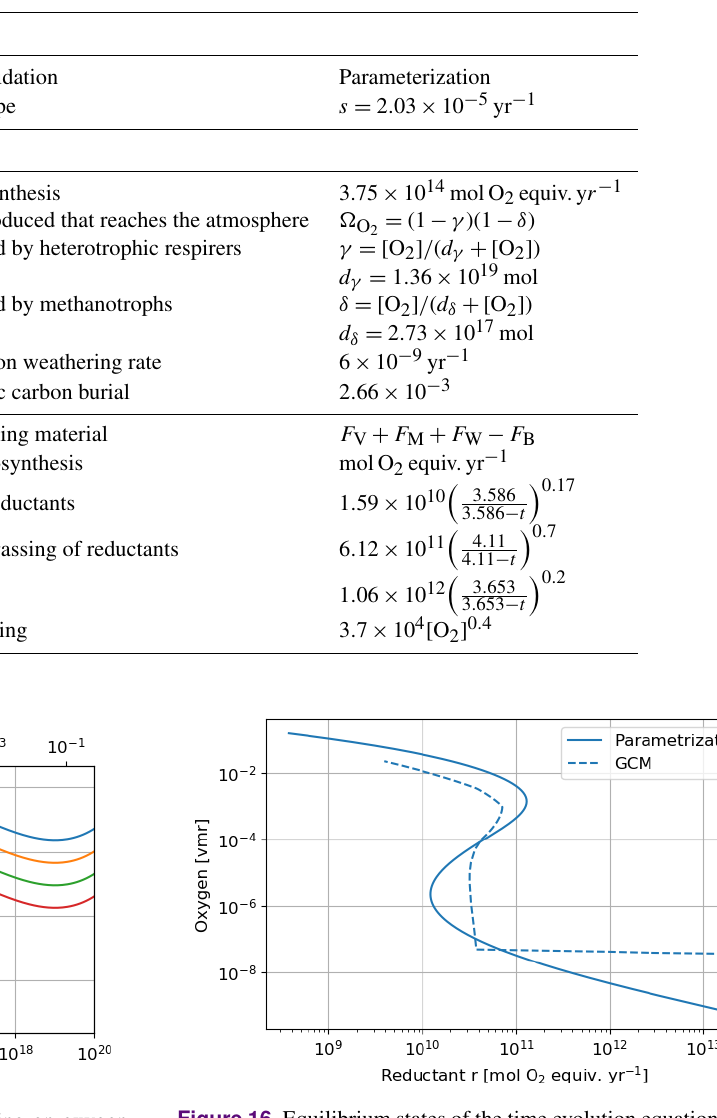
Figure 15. Oxygen atmospheric loss ( F O and methane; labeled in VMR. Goldblatt et al. (2006) parameteri- zation (solid) and GCM 1D results (dashed).